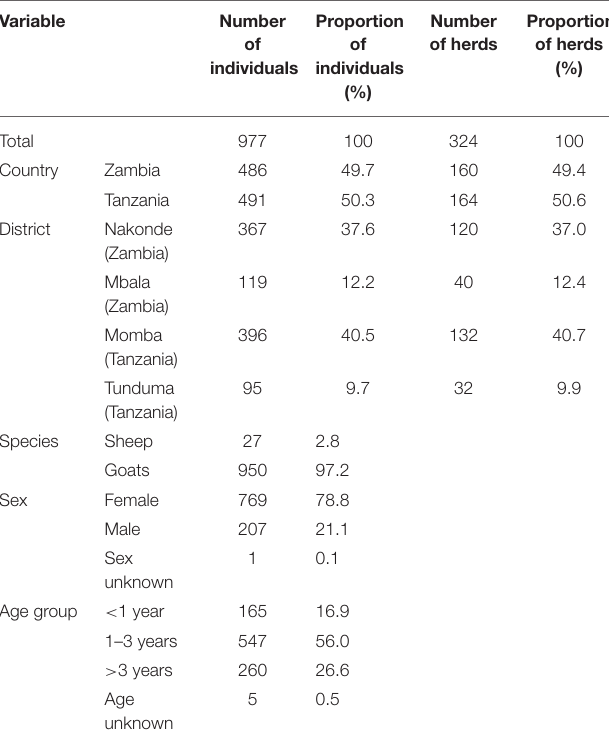
Proportion of herds